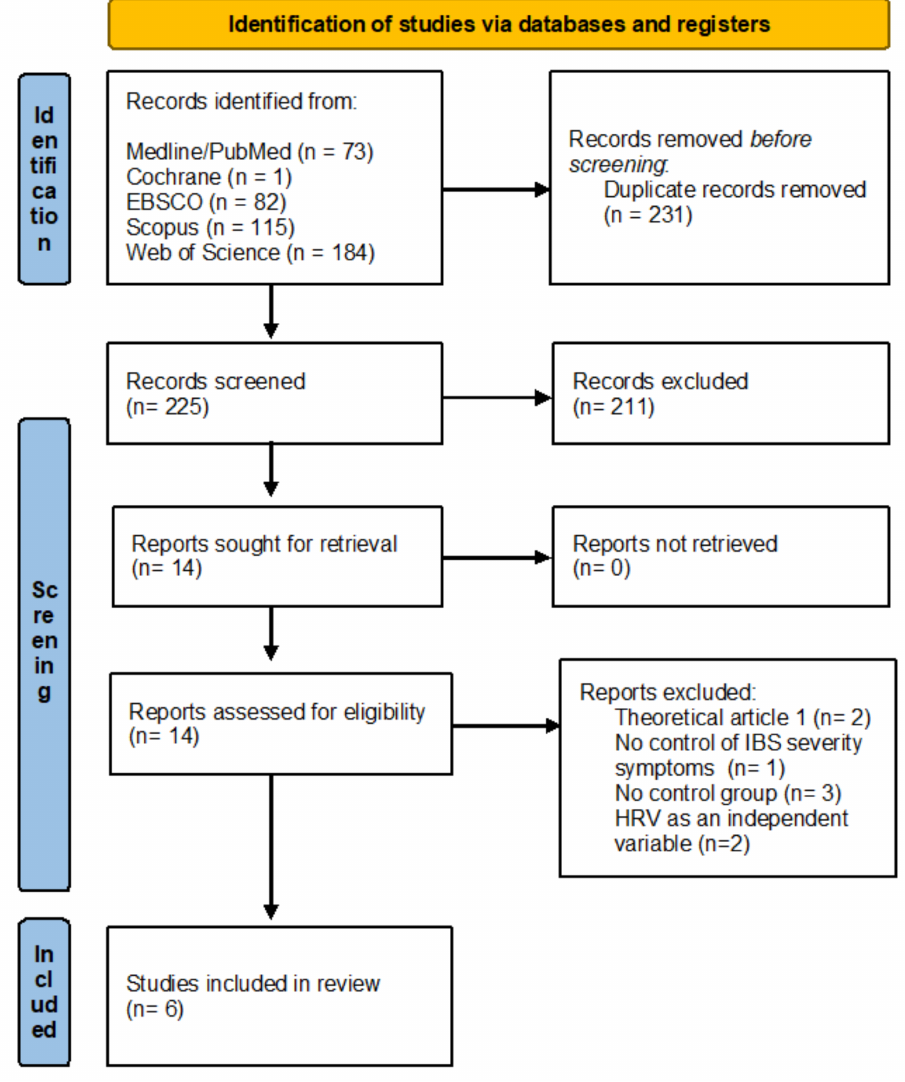
Figure 2. Flow diagram for systematic